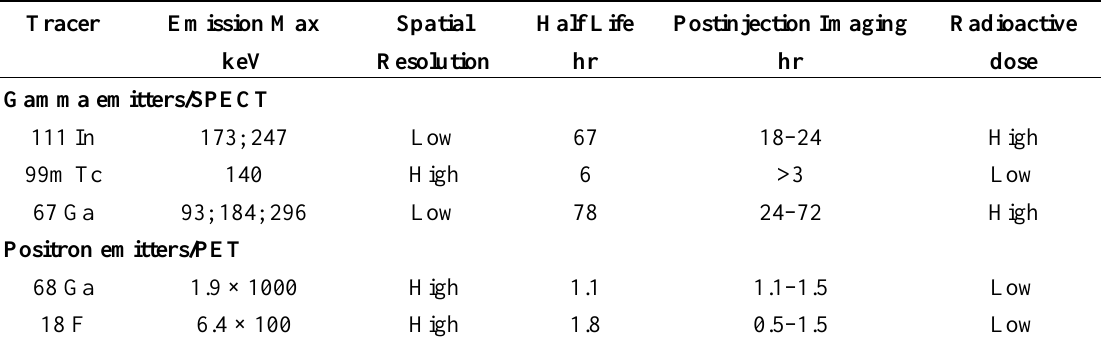
Table 2. Common radioisotopes used in infection